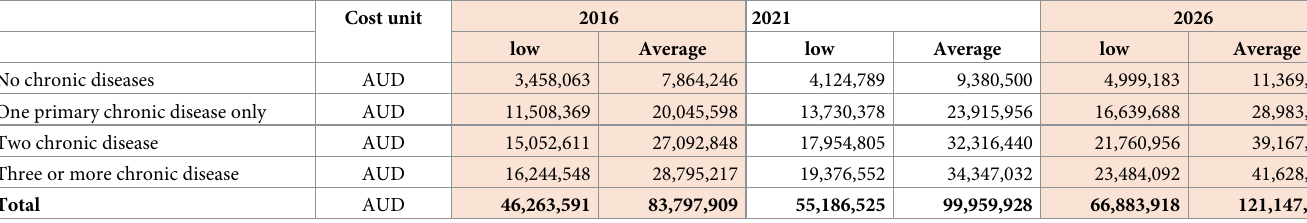
Table 10. Cost estimation for assistive technologies.